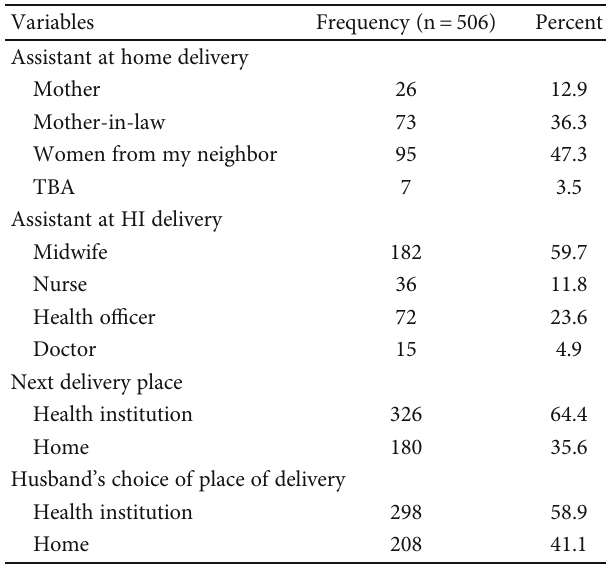
Table 3: Last delivery assistance among the woman respondents, in Jimma Arjo District, Oromia, Ethiopia,